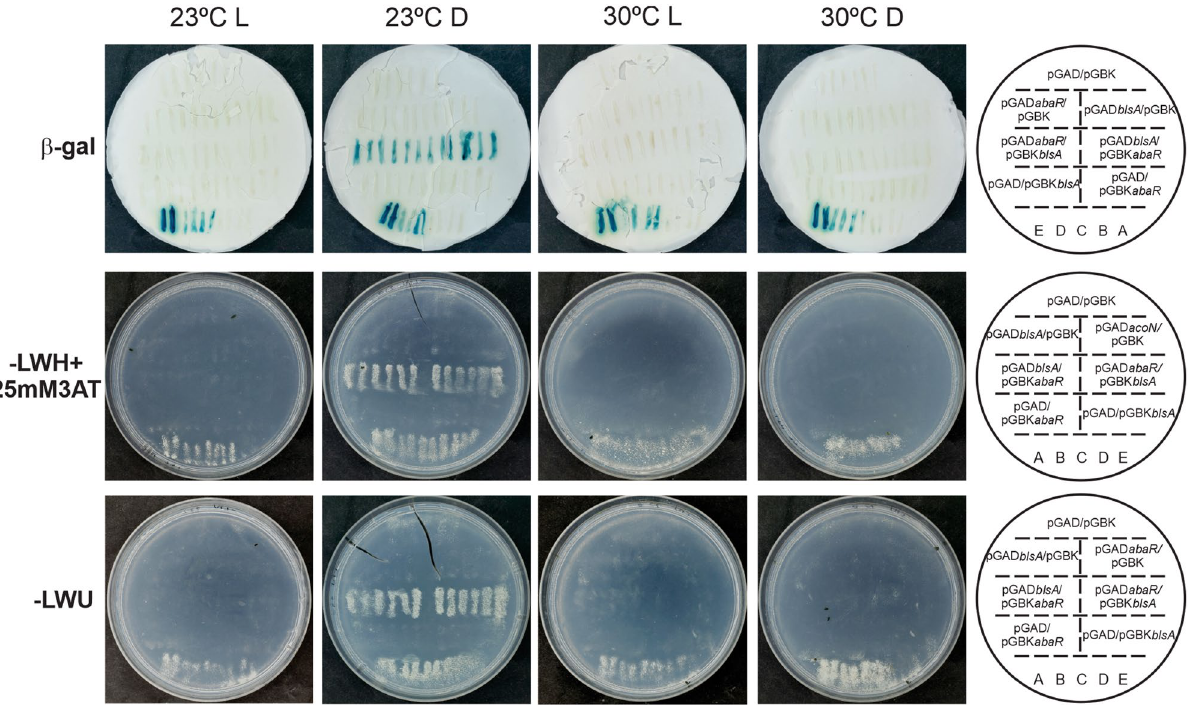
Figure 5. BlsA–AbaR interaction studied by Y2H assays. Six clones of MaV203/pGAD- blsA or MaV203/ pGAD- abaR transformed with plasmids pGBK- abaR or pGBK- blsA , respectively, as well as plasmid pGBK-T7 or pGAD-T7 as negative control, were patched in each plate. Also included are reciprocal combinations, and self-activation as well as different strength interaction controls (strains A–E). The description and order of yeast streaks on each plate are indicated in the scheme on the right. Results for the lacZ reporter, the histidine auxotrophic marker and the uracil reporter are indicated in the top, middle and bottom panels. Experiments were performed in triplicate and representative results are